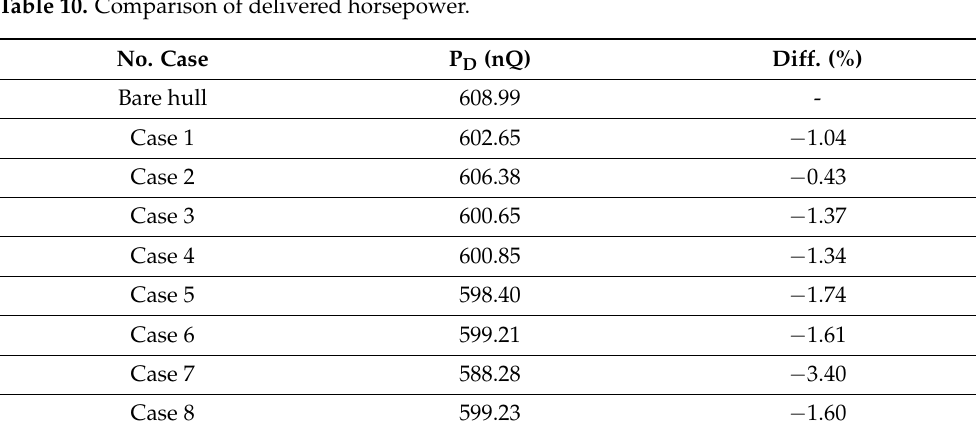
Table 10. Comparison of delivered